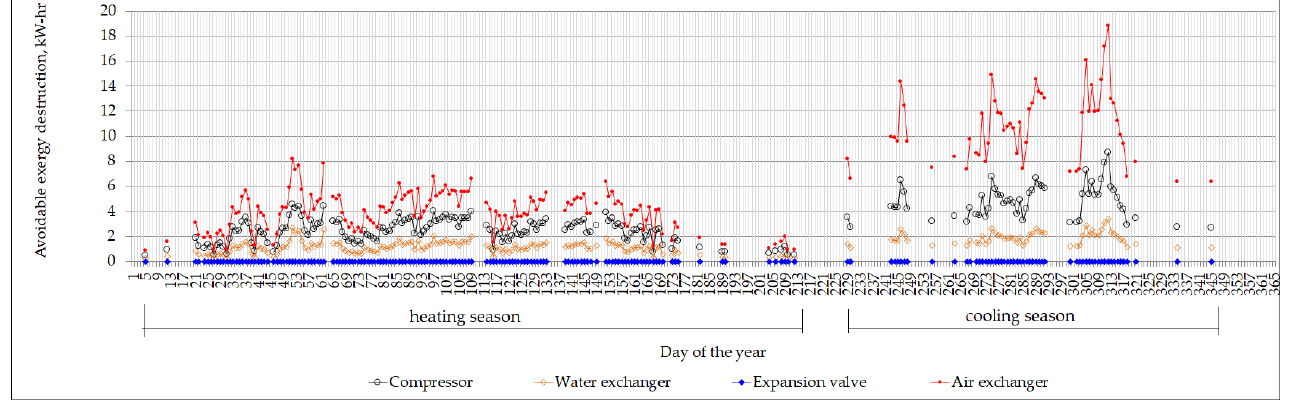
Figure 5. Distribution of daily internally caused and externally caused avoidable exergy destruction, ∑ E AV ,INT,EXT,daily , (kWh) within the components of the investigated reversible heat pump operating D,k with R290 over a year.